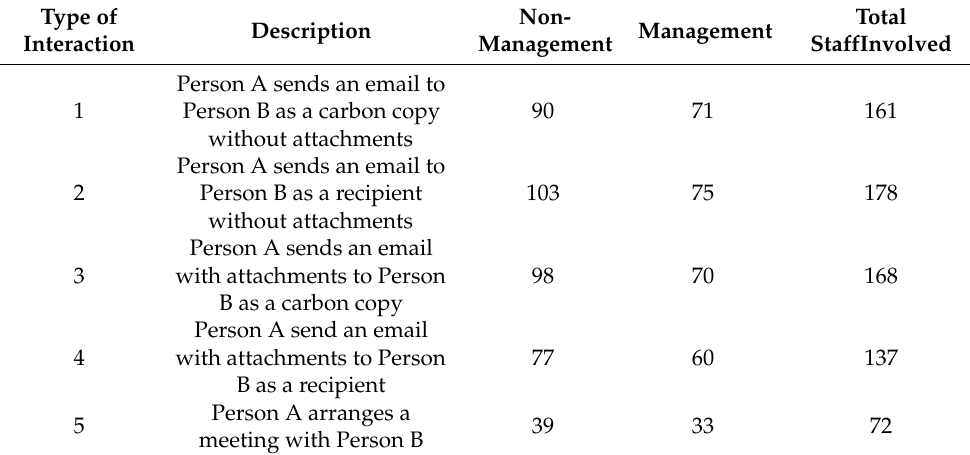
Table 6. Number of staff involved in different types of